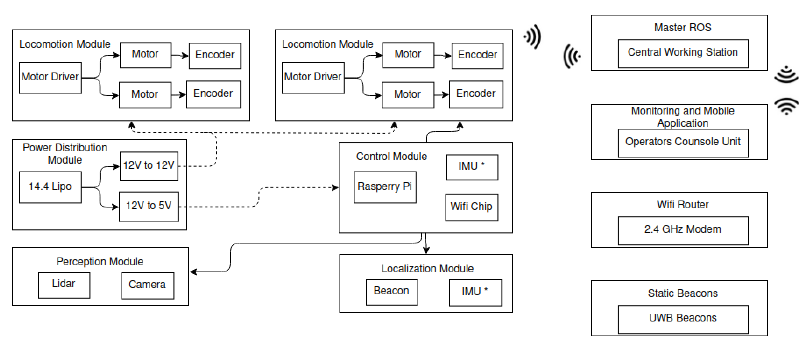
Figure 3. System